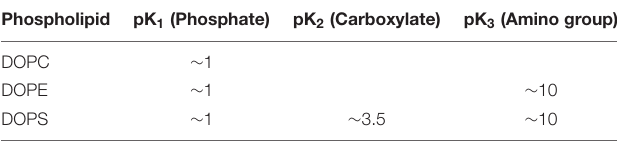
TABLE 1A | pK values for the phospholipid head groups used in this